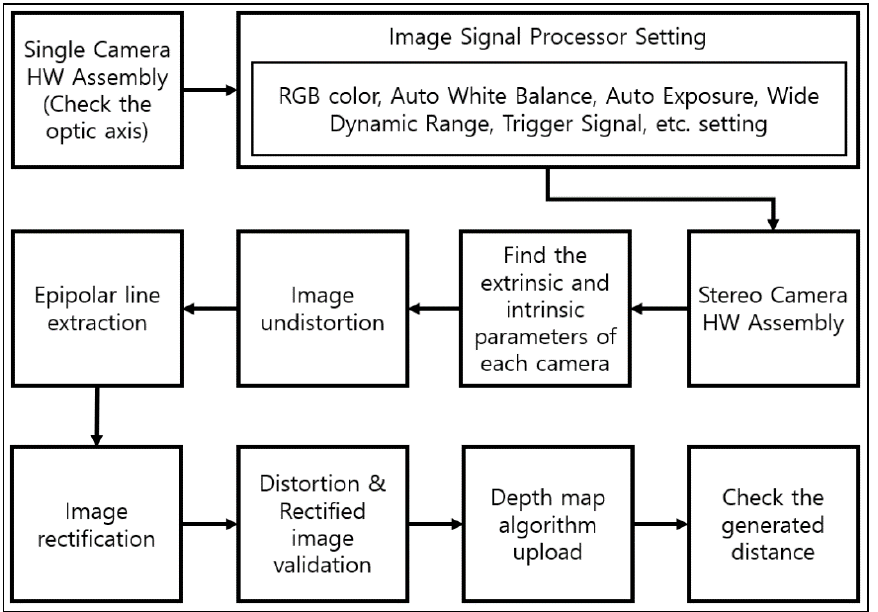
Figure 1. The process of making a stereo camera.